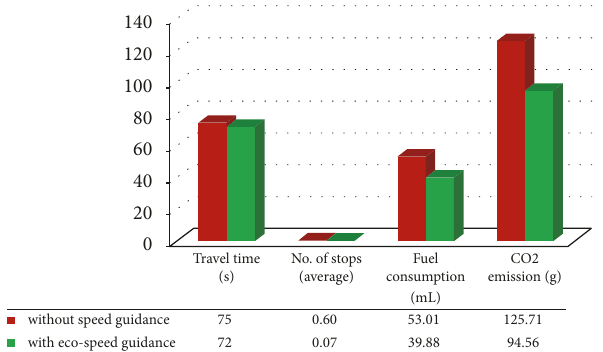
Figure 8: Comparison of evaluation indexes for the vehicles with and without speed